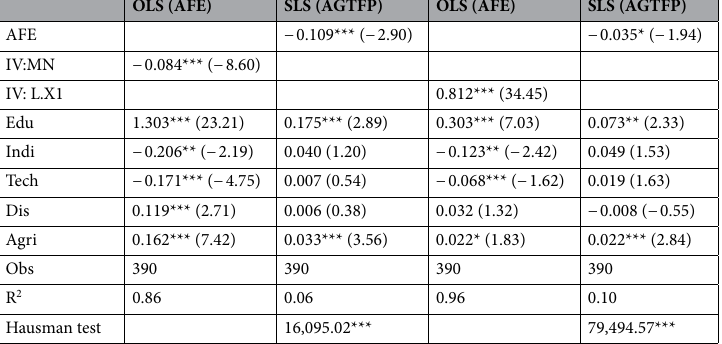
Table 9. Regression results of instrumental variable. *, **, *** indicate significance at the 10%, 5% and 1% level. For the estimated coefficients, the standard errors are in